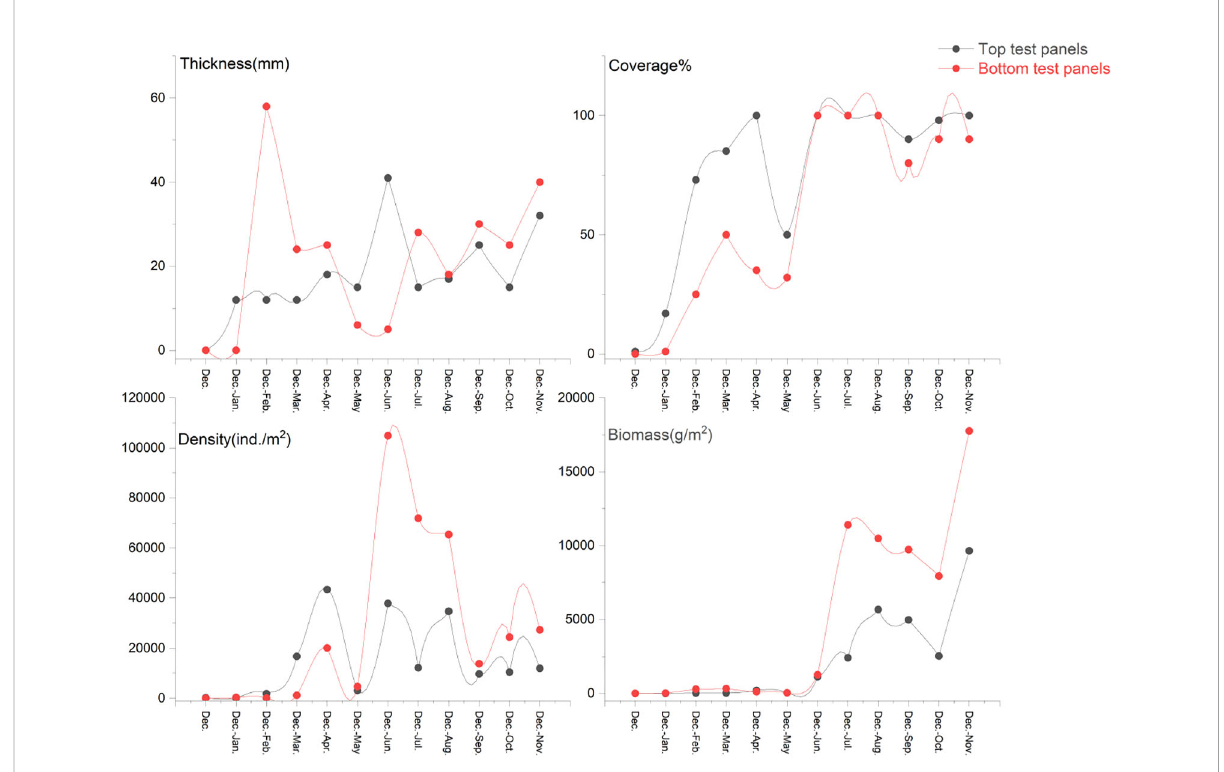
FIGURE 8 The attachment thickness, coverage, density and biomass of